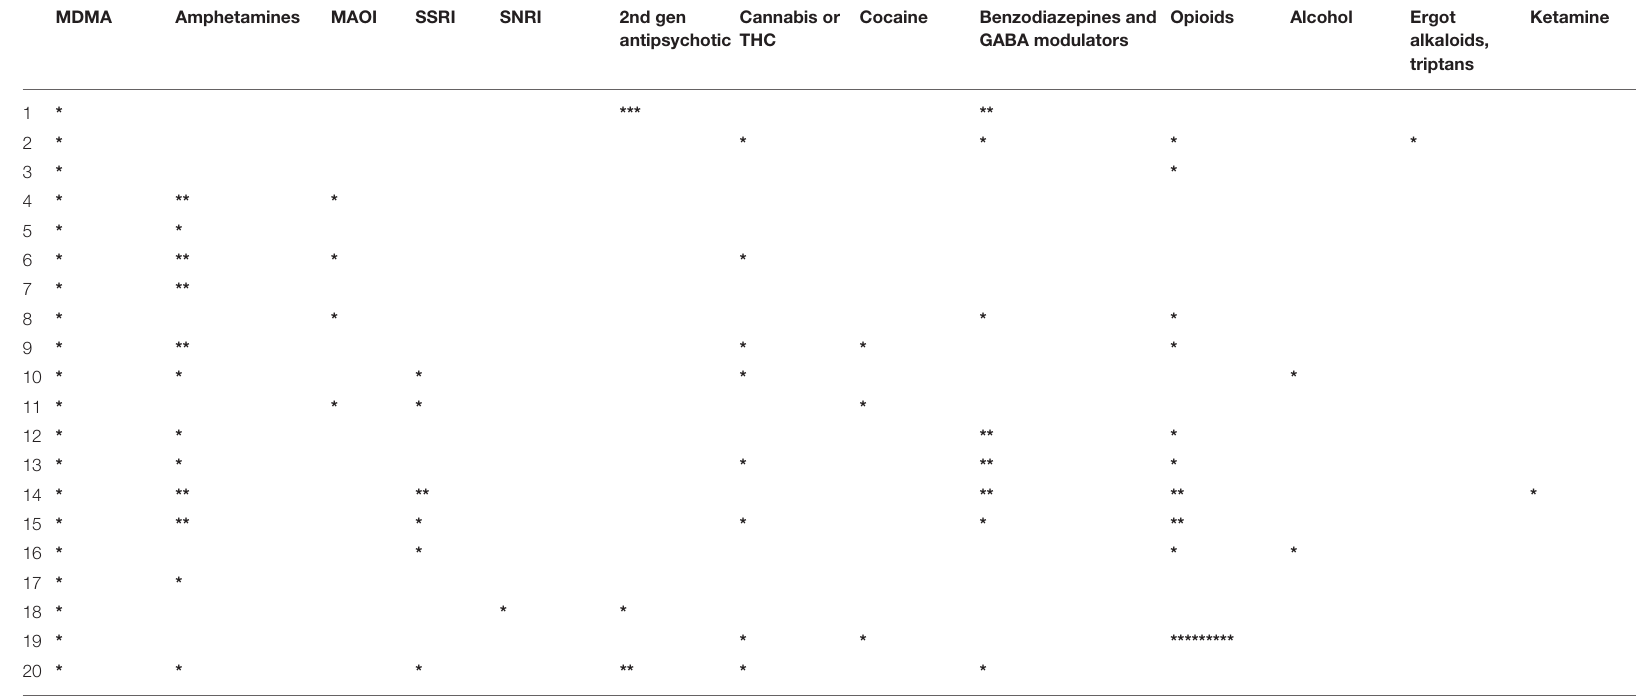
TABLE 2 | Psychoactive concomitant drugs, summarized by class, in serotonin syndrome/MDMA